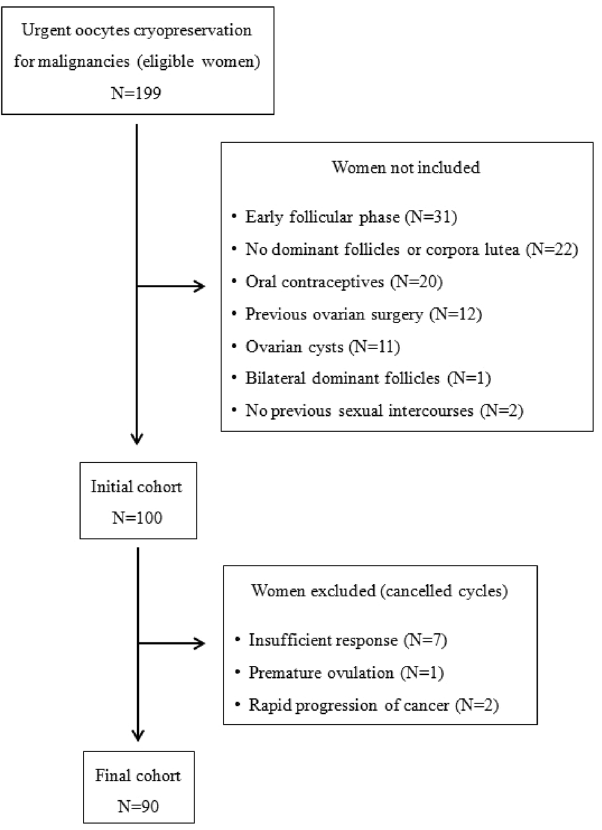
Figure 1. Flow-chart of the selection phase. Overall, more than half of the eligible women could not be informative because they did not fullfill our selection criteria (109 out of 199). The most common reason for exclusion was the referral in the early menstrual cycle phase (N = 31), the absence of dominant follicles or corpora lutea at basal ultrasound (N = 22) and the assumption of oral contraceptives (N =